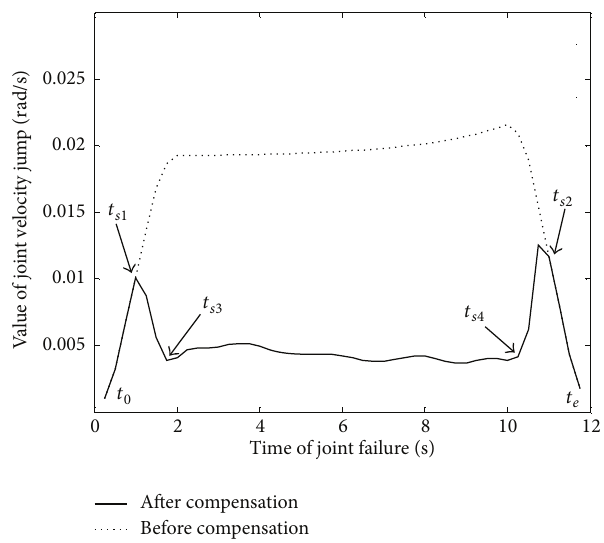
Figure 9: Joint velocity jump comparison along the task